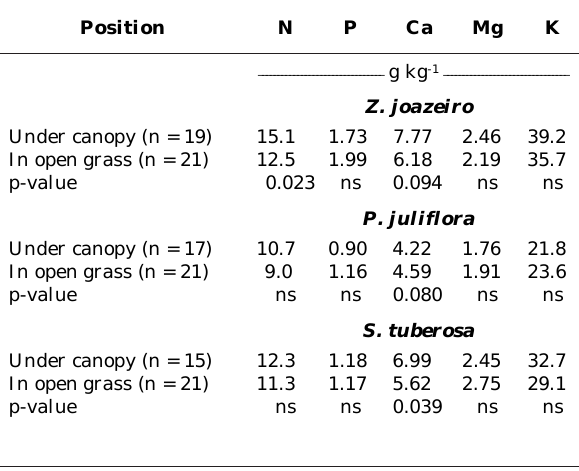
Table 4. Sample medians and ranges of forb tissue nutrient concentration under and outside (open grass) the canopy of Z. joazeiro , P.